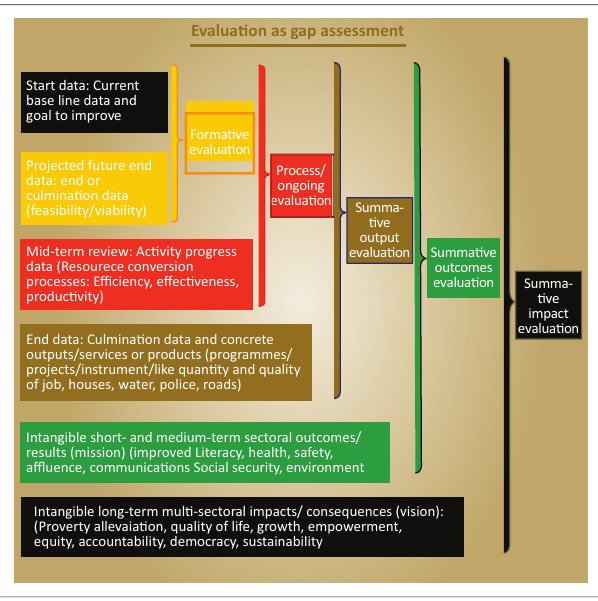
FIGURE 1: Cloete’s model of evaluation as gap assessment.